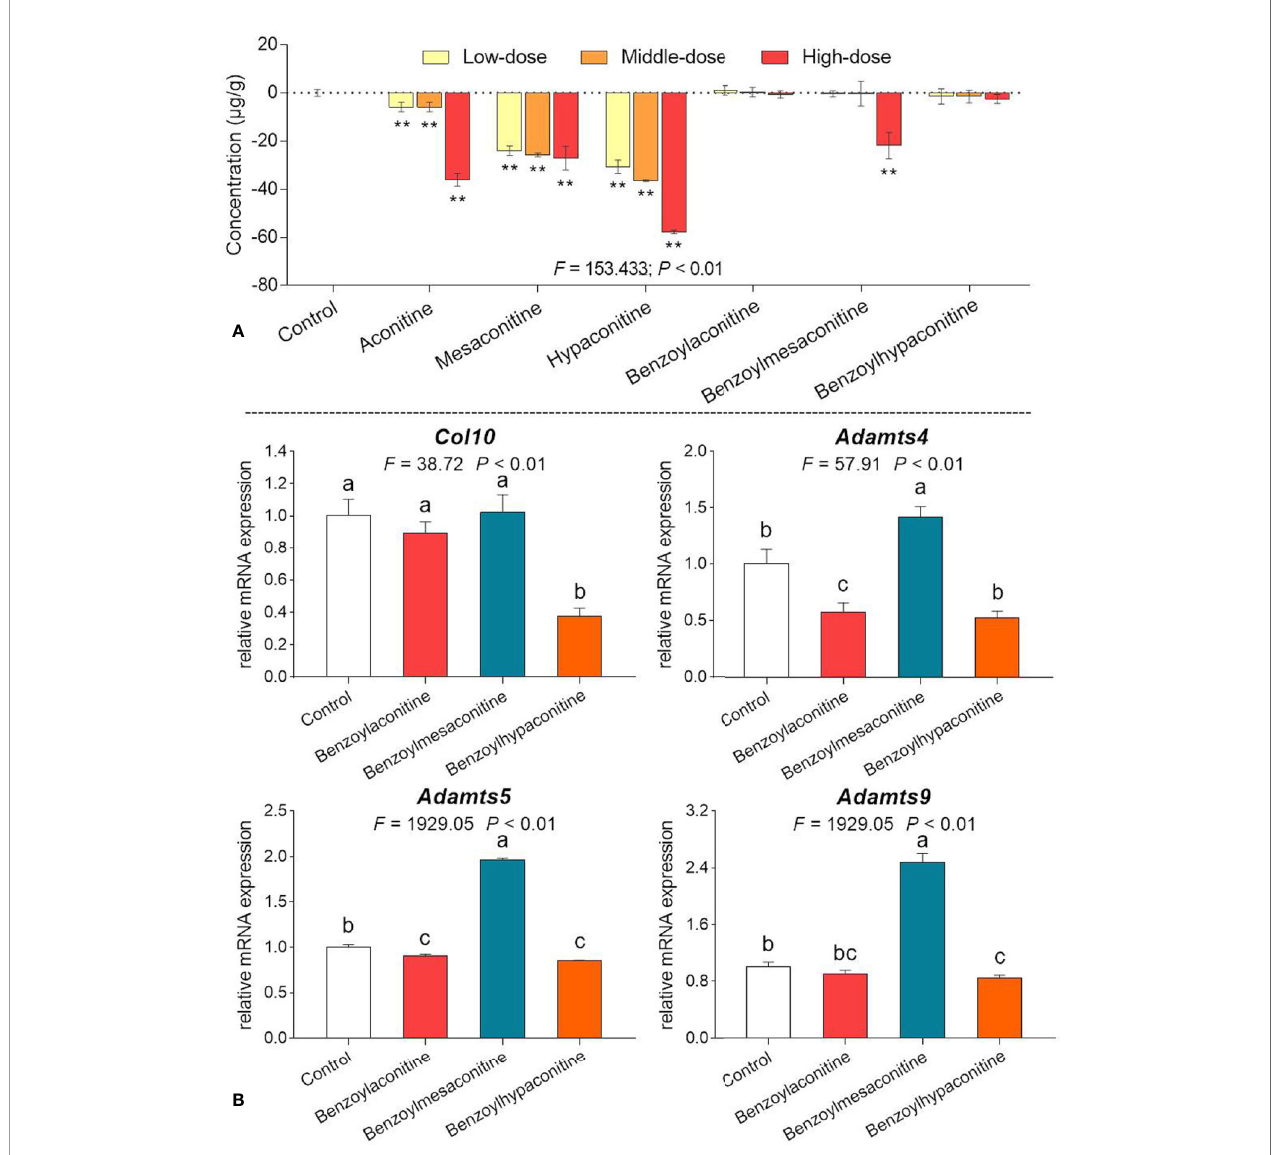
FIGURE 6 | Cell viability of chondrocytes with treatments of aconitine, mesaconitine, hypaconitine, benzoylaconitine, benzoylmesaconitine, and benzoylhypaconitine (A) and relative mRNA expressions of OA-related genes in chondrocytes with treatments of benzoylaconitine, benzoylmesaconitine, and benzoylhypaconitine (B) . Values are presented as mean ± SD. By means of LSD multiple comparisons, data with same lowercase letter indicate no signi fi cant difference between each other, while data with different letters indicate signi fi cant difference with each other. **P<0.01 vs. control